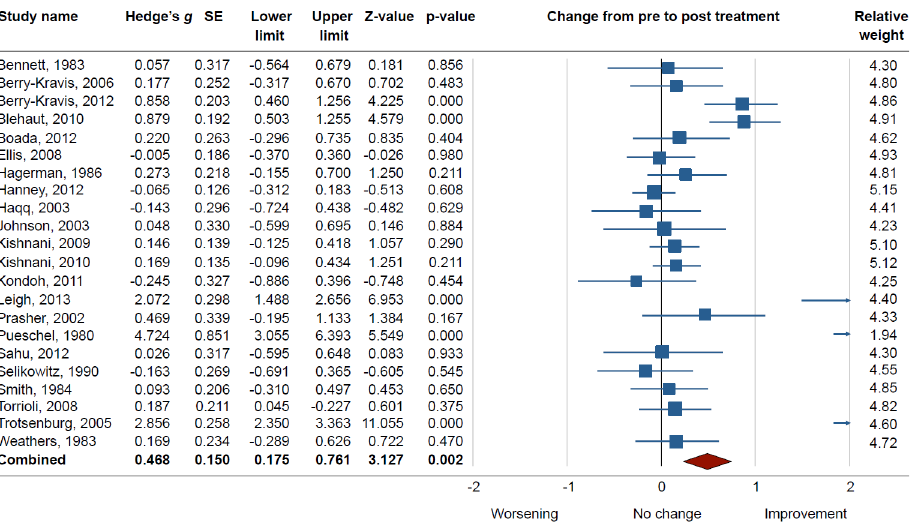
Fig 2. Forest plot of placebo responses in patients with Intellectual Disability. A significant placebo response was found from pre to post treatment (p = 0.002) across all studies. If studies included more than one outcome measure they were combined into one value. A random-effects model was used to calculate significance. There was a medium overall effect size, which is comparable to the placebo effect size in studies with patients who are not intellectually disabled [47, 48].